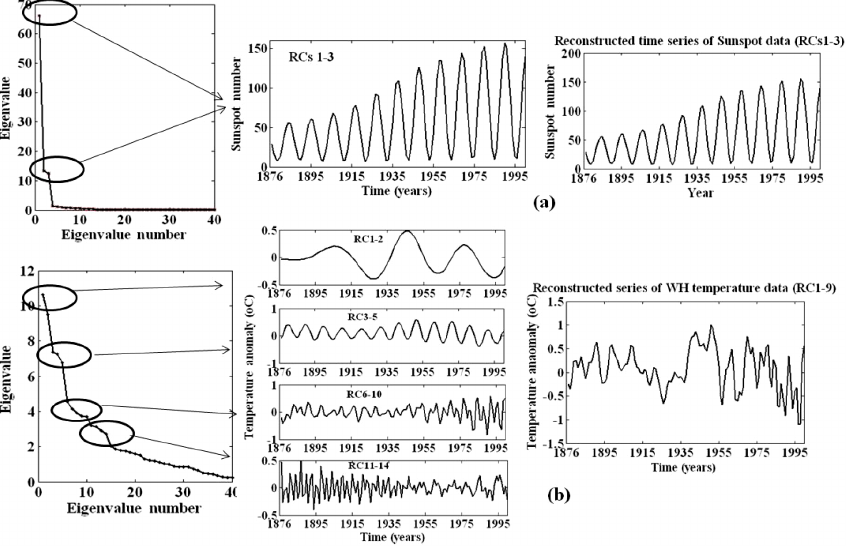
Figure 7. Singular spectra with their SSA decomposed components and their reconstructed time series for (a) SOI and (b) geomagnetic activity (aa indices).